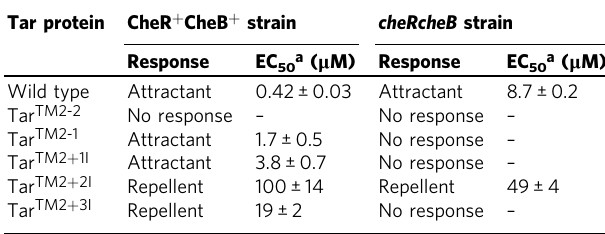
Table 1 Responses of the wild-type and mutant Tar